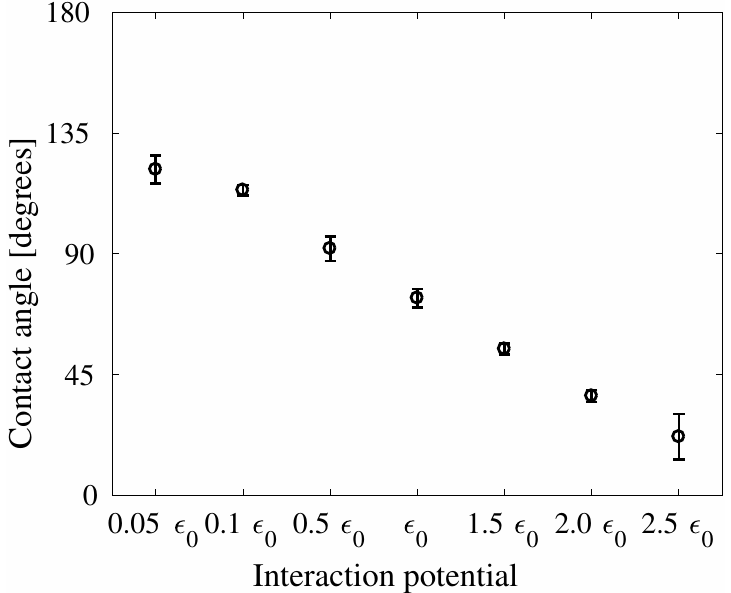
Figure 5. Water contact angle θ as function of the interaction potential ε for the System A. The values of ε can be found in Table